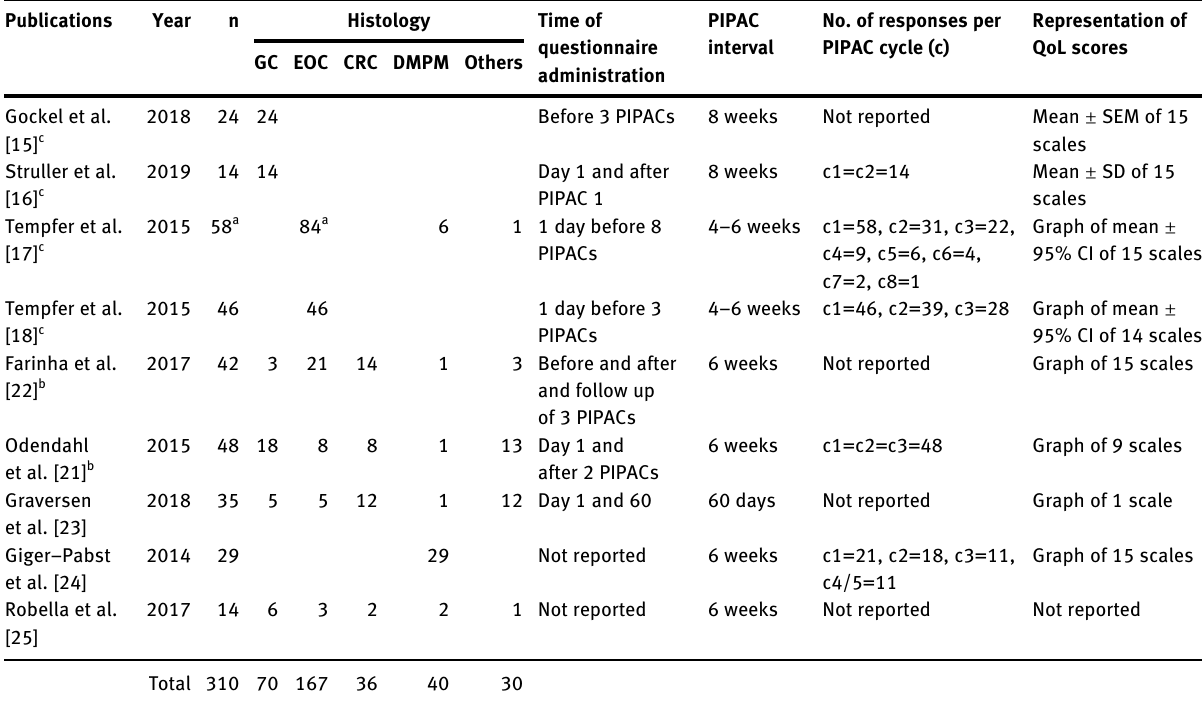
Table  : Details and characteristics of the relevant nine studies identi fi ed.